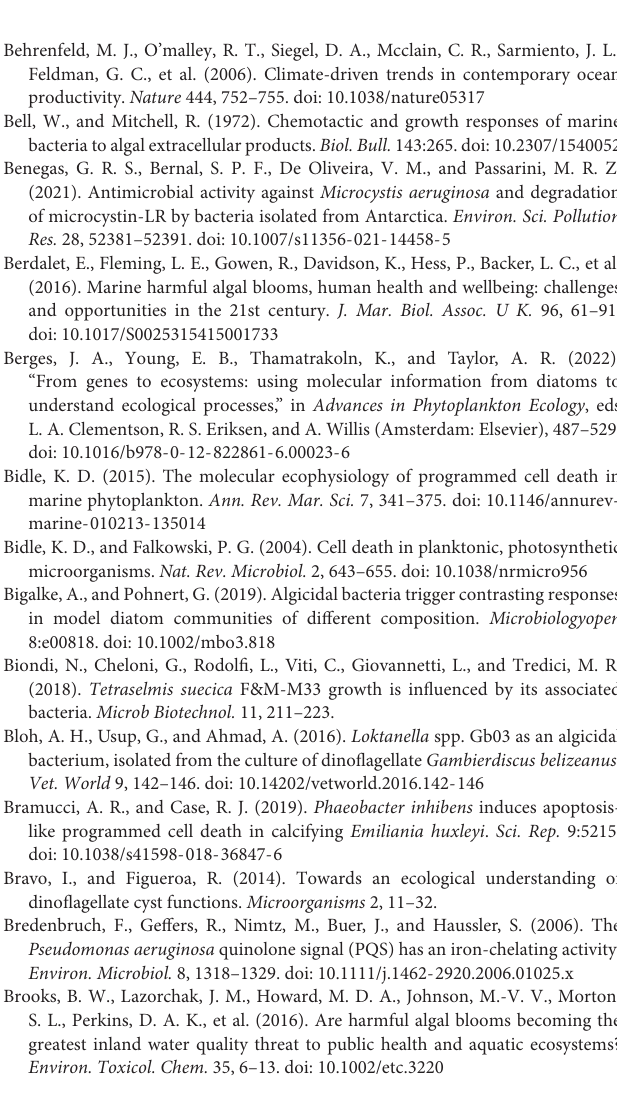
Supplementary Table 1 | Detailed list of papers reviewed,